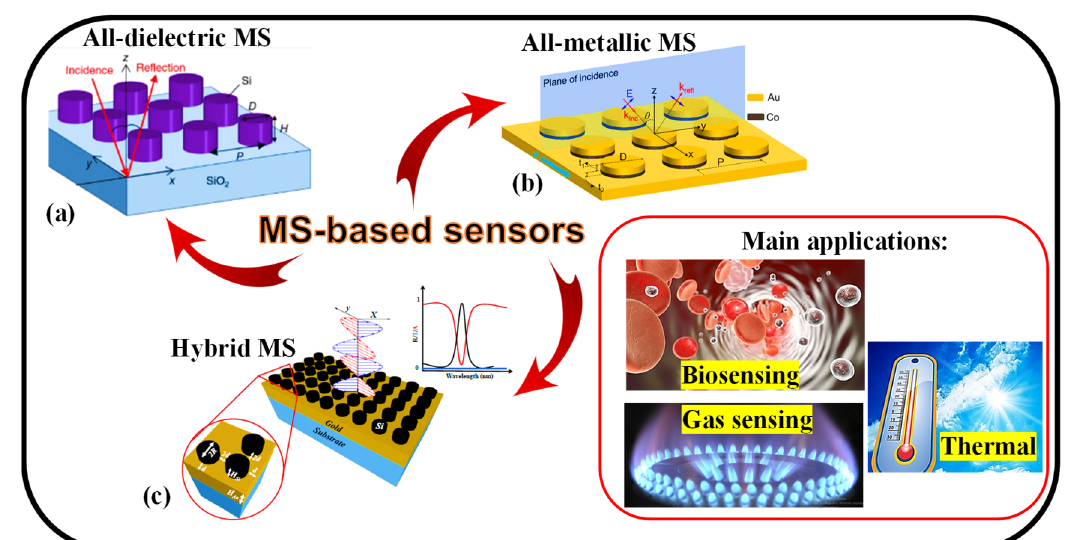
Figure 2. Types of MS such as ( a ) All-dielectric MS [81], ( b ) All-metallic MS [82], and ( c ) Hybrid MS [83], for biosensing [84], gas sensing [85], and temperature sensing applications [86].